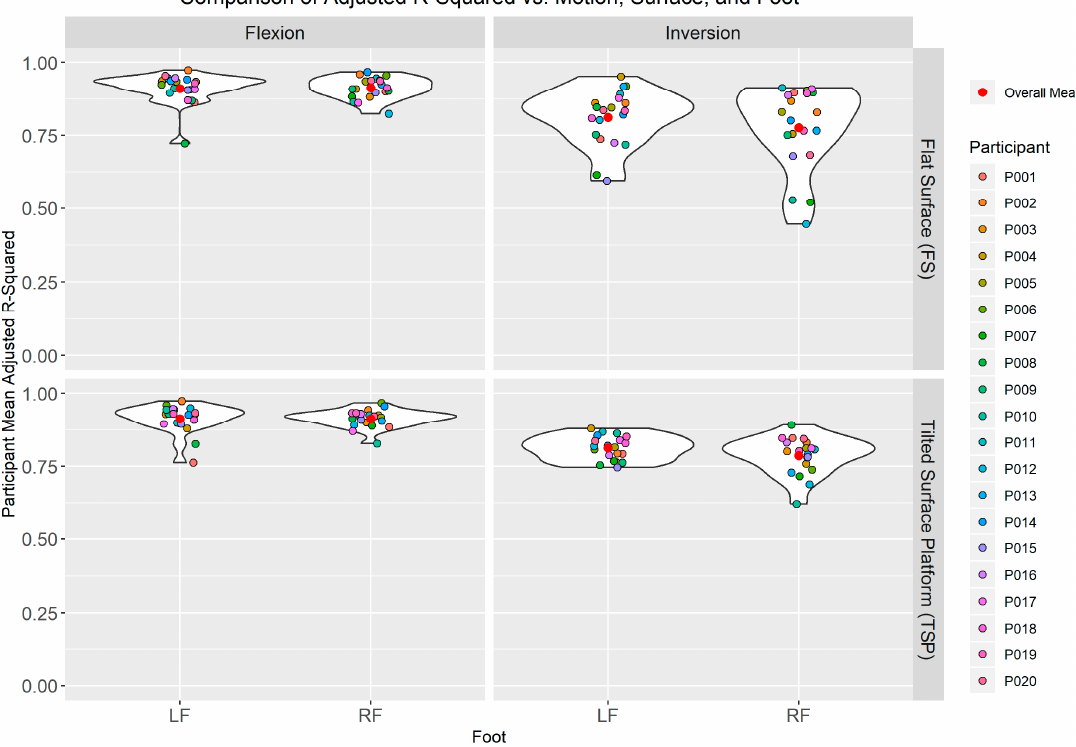
Figure 8. Violin plot of adjusted R 2 metric showing mean and spread of results with respect to various factors. Colored points represent individual participant means. Flexion and inversion columns represent the motion that was being predicted. Rows represent the two types of surfaces the participant walked on. Left foot and right foot sensors are represented in the graph as LF and RF, respectively.